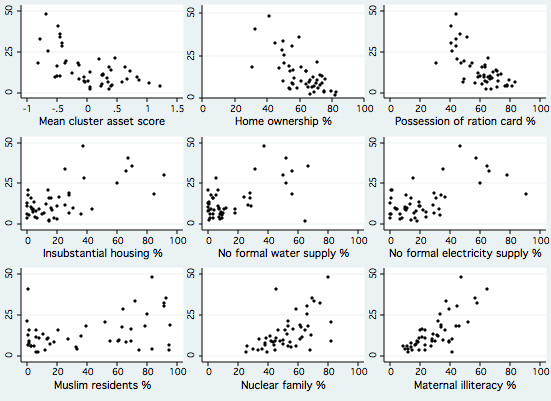
Scatterplots of home births (%, as y axis) against nine independent cluster-level variables, for 10 754 deliveries in 48 Mumbai slum areas, 2005-2007.